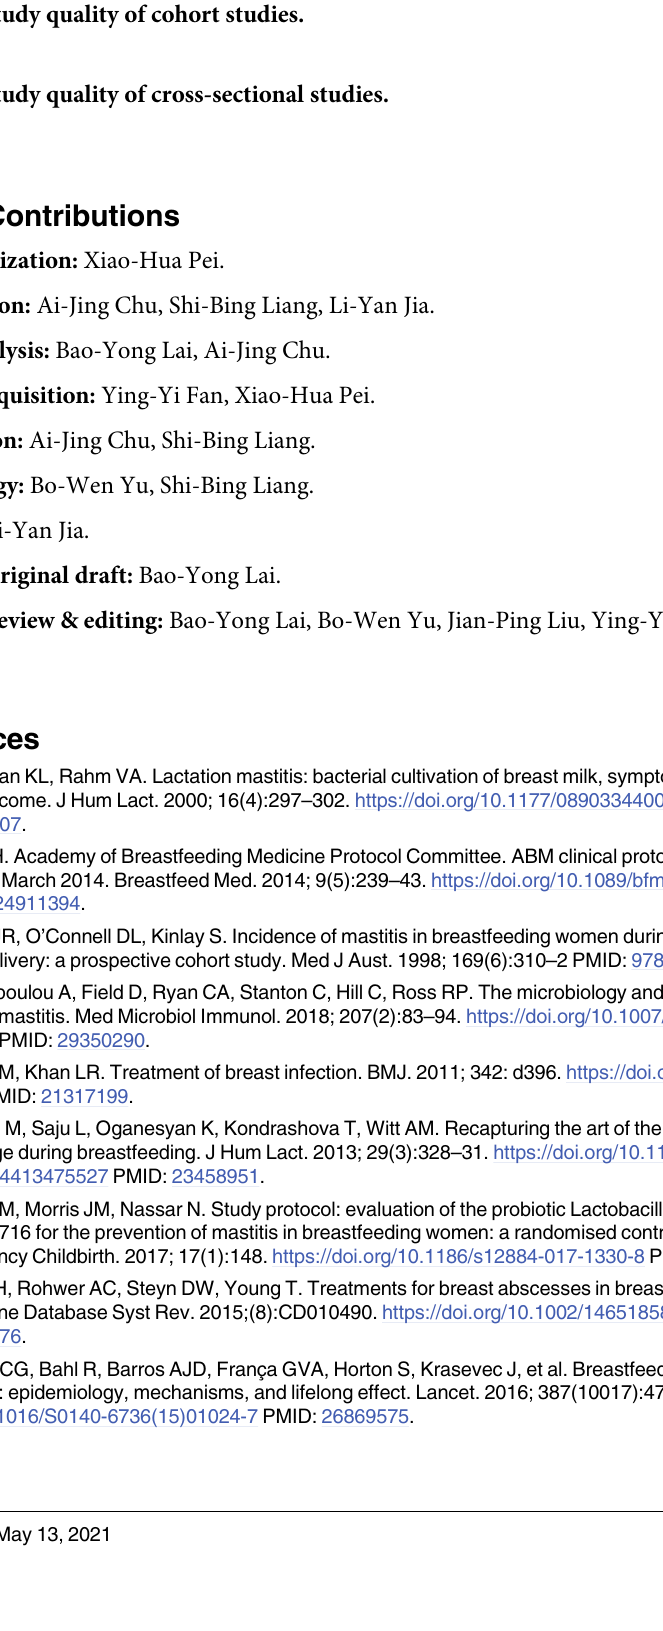
S1 Table. Study quality of case-control studies. S2 Table. Study quality of cohort studies. S3 Table. Study quality of cross-sectional